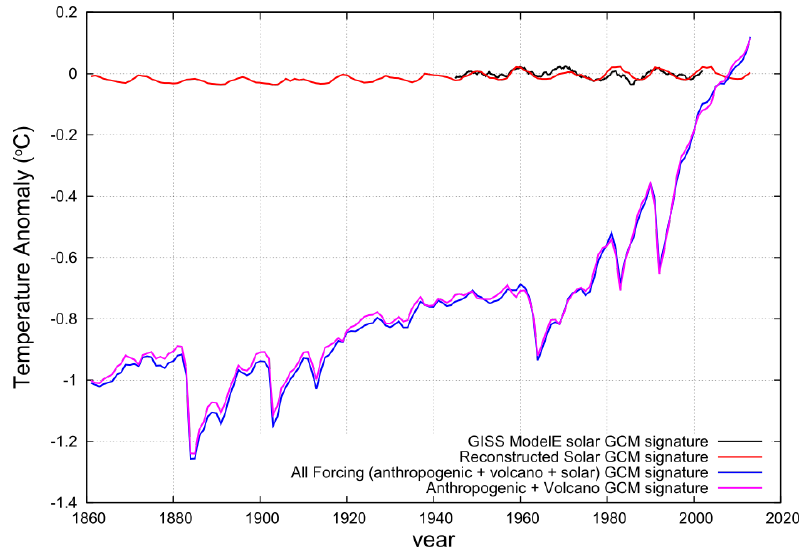
Figure 5. (Black) solar signature at the surface reproduced by the GISS ModelE from 1945 to 2003 [68,120]. (Red) reconstruction of the solar signature modeled by the global circulation models (GCMs) using the total solar irradiance record by Wang et al. [70]. (Blue) CMIP5 multi-model mean simulation (from Figure 1). (Purple) Coupled Model Intercomparison Project 5 (CMIP5) multi-model mean simulation detrended of the solar signature, Equation